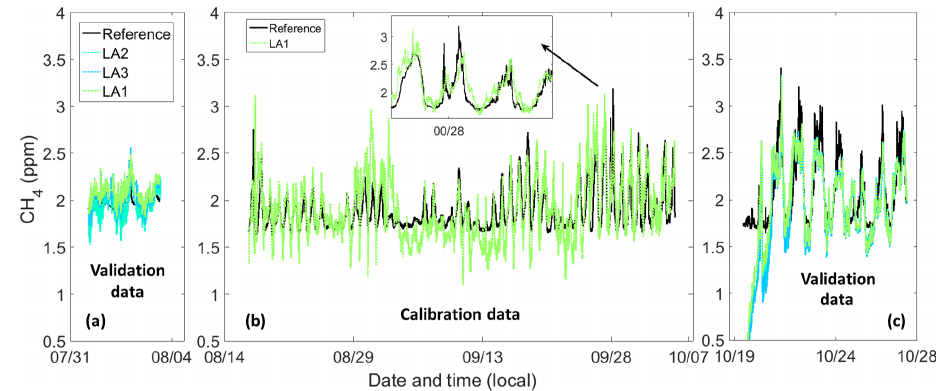
Figure 10. Time series of the universal calibration model (for MDL5_2INT_TR) generated using the Validation 2 period (b) and the ap- plication of the model to the pre- and post-deployment co-location data ( a and c ) for Y-Pods LA1 and the normalized data from LA2 and LA3.